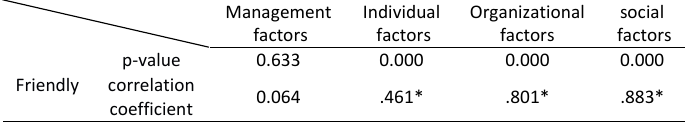
Table 9. Assumption of correlation between algebraic silence variables and silent factors